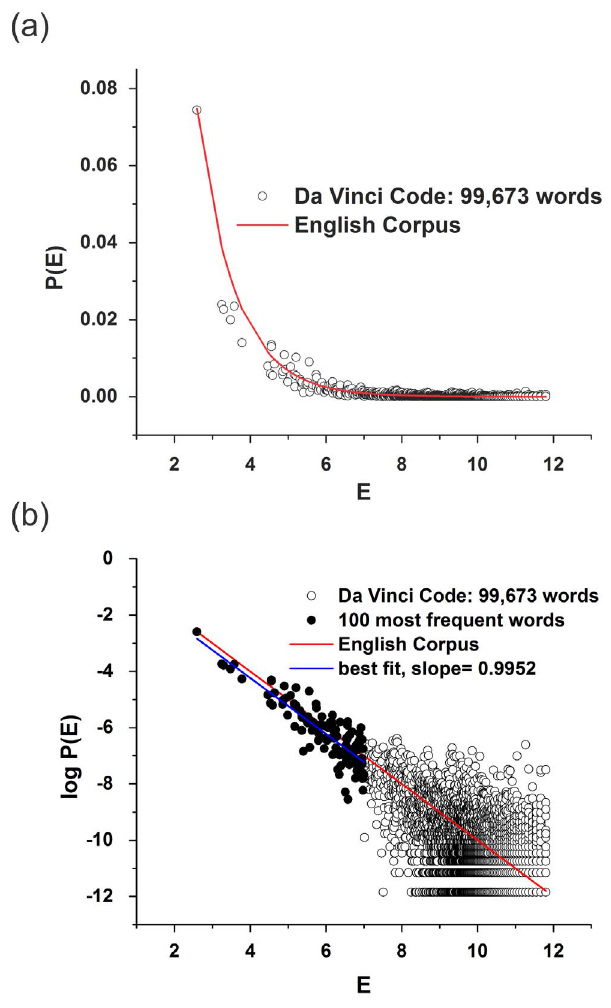
Figure 1. Comparison between distributions of energies for a book and for the corpus standard. The (a) plot of the probability distribution P ( b E ) versus the ‘‘energy’’ E associated to a given word in the vocabulary of the book The da Vinci Code by Dan Brown in its English version, compared with the standard curve for the Brown corpus; and (b) its respective semi-log plot. This book contains 99,673 distinct words, named as ‘‘items’’ at the plot that shows only 5,529 different words. To calculate the fit (green line), we considered only the points in red ( * 100 ), where we choosed the maximum energy as being lower than 7. An increase in the number of points up to 1,000 (interval where the Zipf law is still valid) shall not change the result in a significant